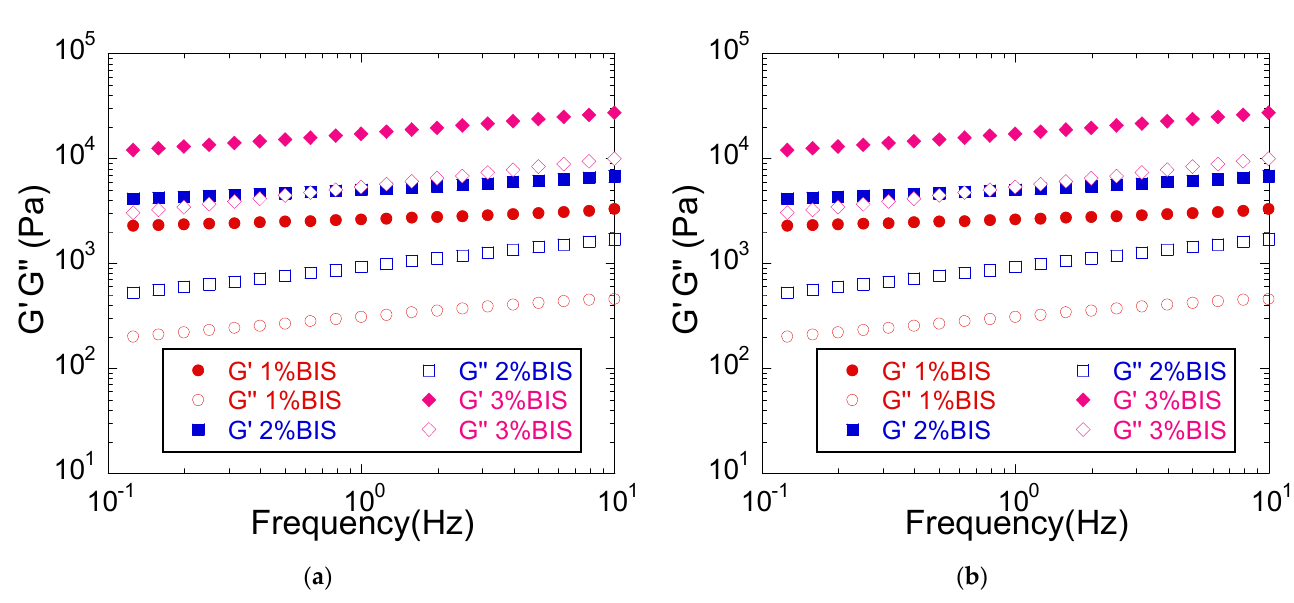
Figure 3. The influence of the crosslinking agent concentration on the viscoelastic properties of PMAA hydrogels ( a ) Amplitude sweep measurements ( b ) Frequency sweep measurements. Hydrogel composition: BIS, 10% MAA based on the whole hydrogel composition, 0% MMT. Table 3. Dependence of the viscoelastic moduli (frequency sweep measurements) and some structural network parameters on the crosslinking agent concentration a .